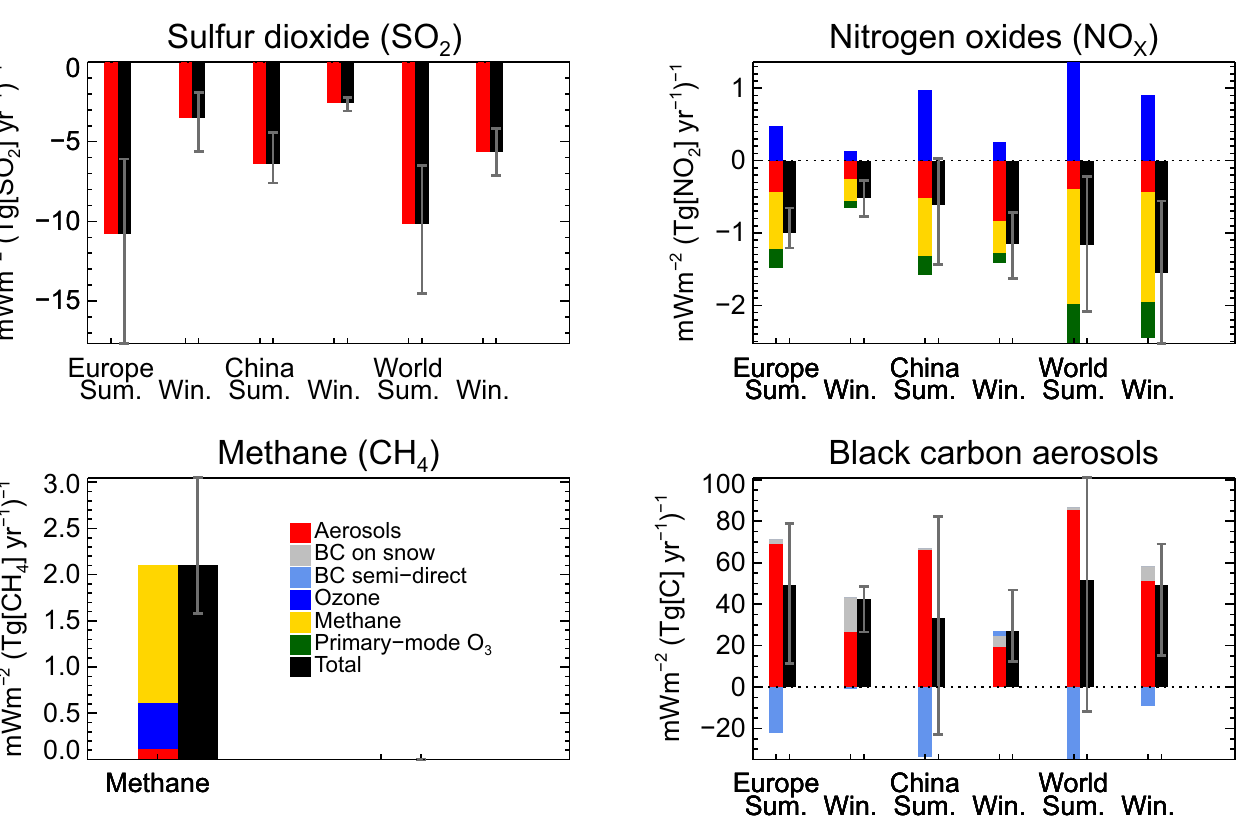
Figure 7. The ECLIPSE estimates of specific radiative forcing (SRF; mWm − 2 per Tgyr − 1 of emission rate change) for reductions in the emissions of SO 2 , NO x , CH 4 , and BC aerosols in Europe, China and the global average, separately for NH summer (Sum., May–October) and NH winter (Win., November–April). Shown are values averaged over all five models, with the error bars indicating the full range of the model estimates. Colours indicate the contribution of different forcing mechanisms. Notice that for CH 4 regionality was not accounted for because, due to its longer lifetime, forcing does not depend on the emission